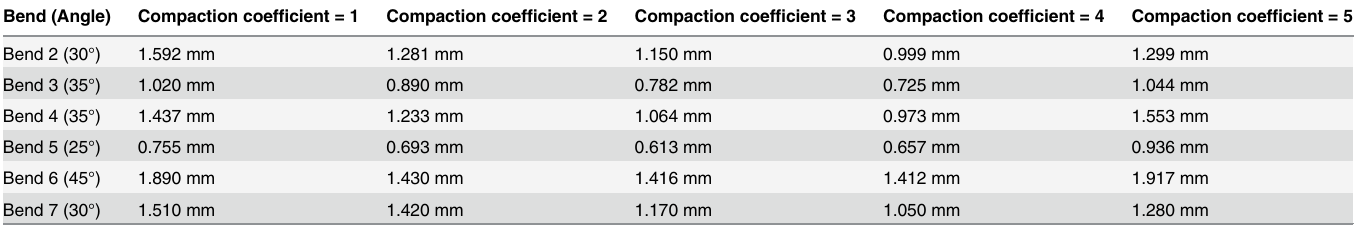
Table 15. Comparison of axial displacements of bends (25° – 45°) with different Compaction coef fi cients.